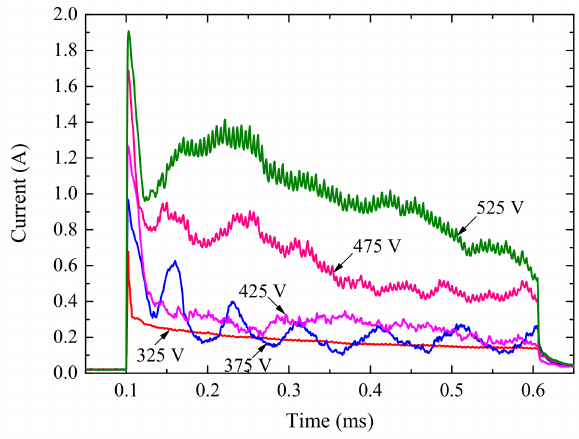
Figure 4. Current transient curves for single pulse anodizing under di ff erent potentials.